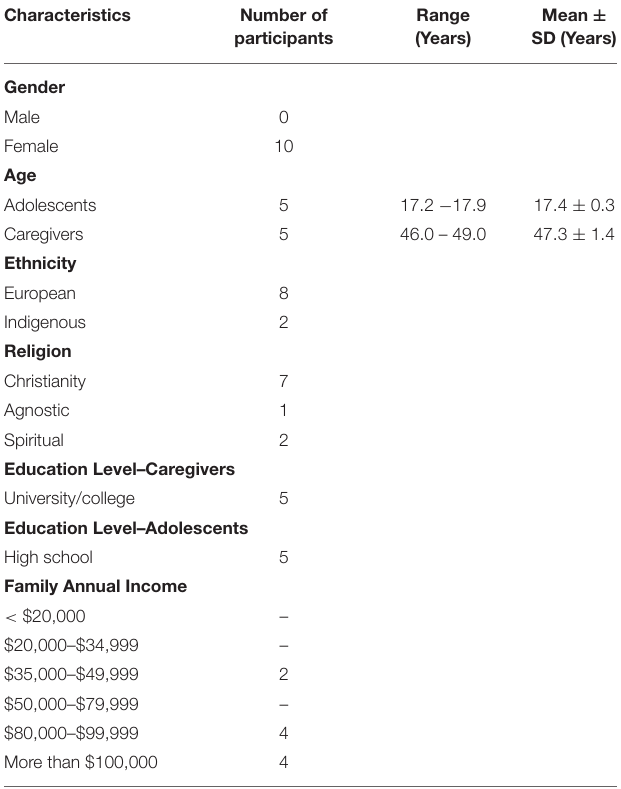
TABLE 1 | Demographic characteristics of study participants.